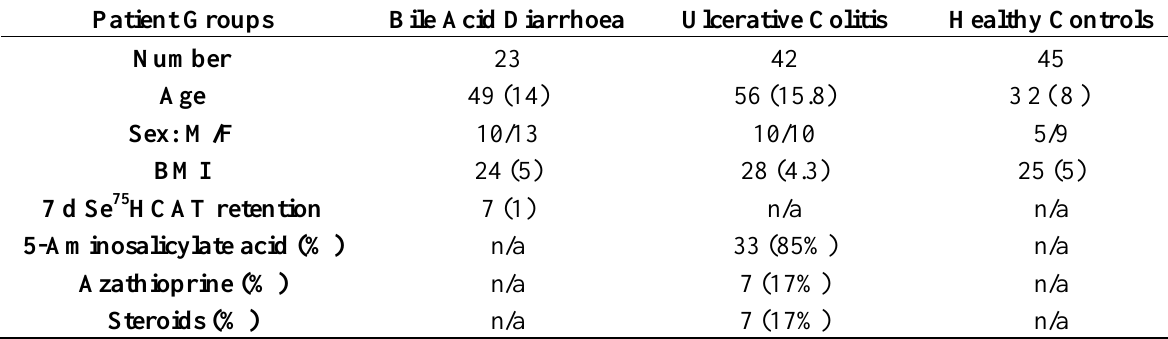
Table 1. Demographic and Clinical Characteristics of the Study